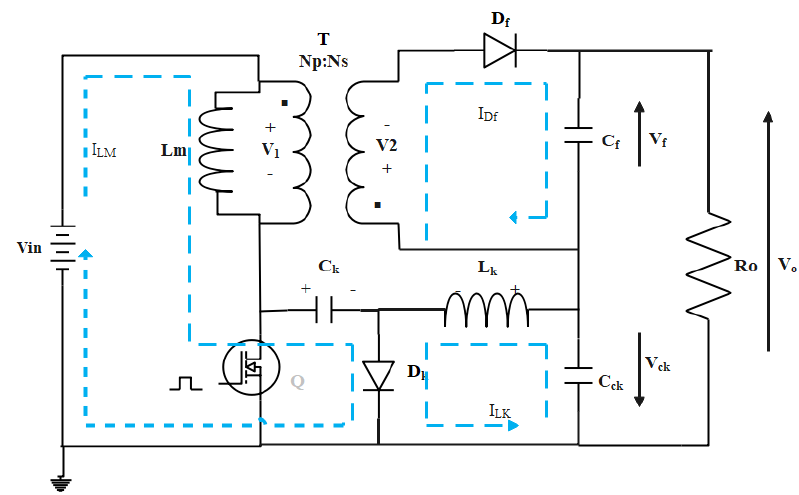
Figure 4. The proposed HFC converter (switch Q is OFF).